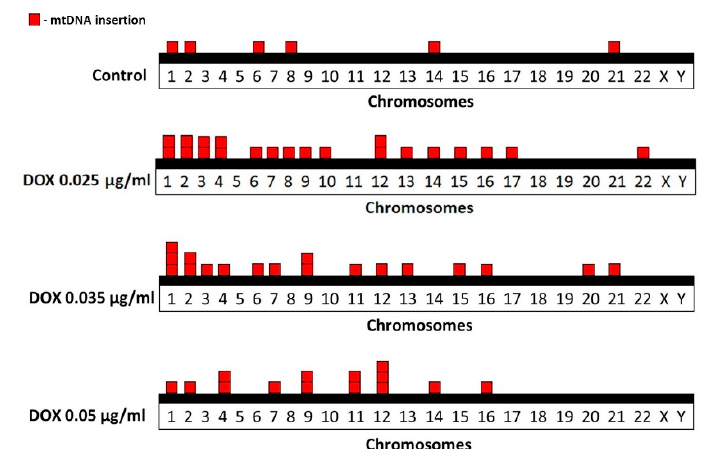
Figure 3. Distribution of spontaneous and DOX-induced mtDNA insertions in human metaphase chromosomes. Each square block corresponds to one insertion event.